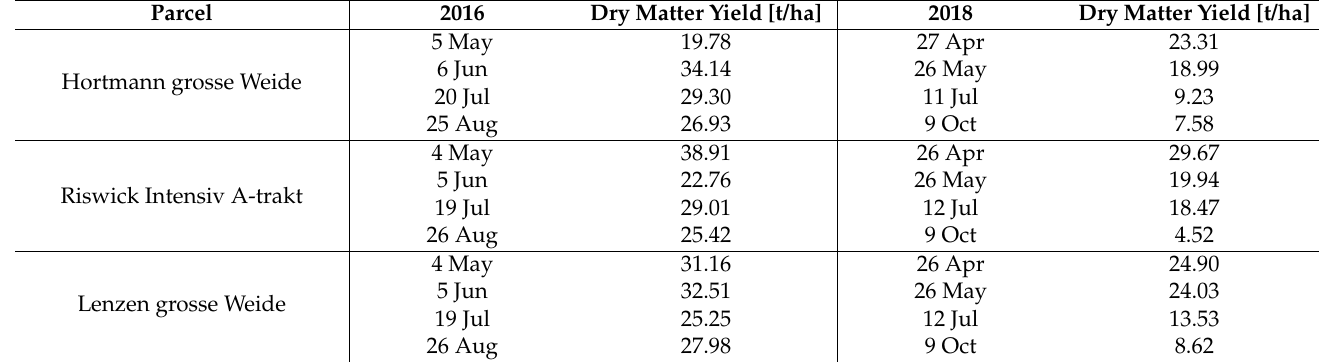
Table 3. Mowing dates and corresponding yield for the three grassland parcels of Haus Riswick for the years 2016 and 2018. Parcel